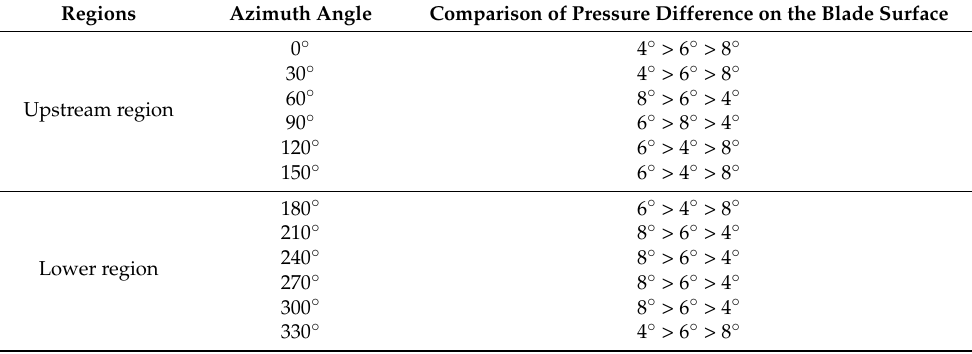
Table 2. Comparison of pressure difference on the blade surface at different blade pitch angles of β = 4°, 6°, and 8°.